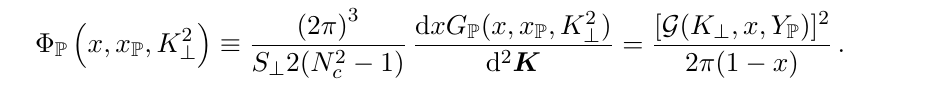
JHEP10(2022)103